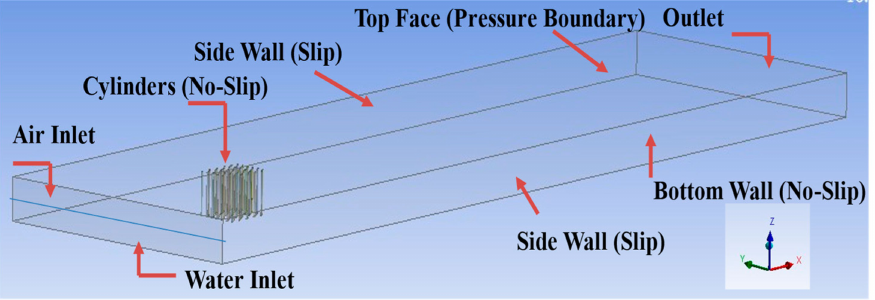
Figure 4. Postprocessing Setups: Boundary